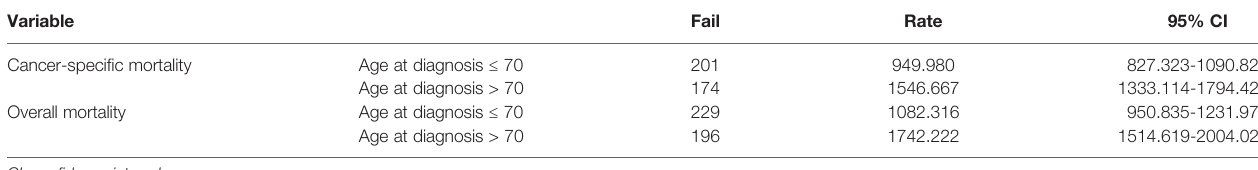
TABLE 4 | Results of 1000-person-years for cancer-speci fi c and overall mortality for anaplastic thyroid cancer patients with a dichotomous cut-off age at diagnosis of 70 years. Variable